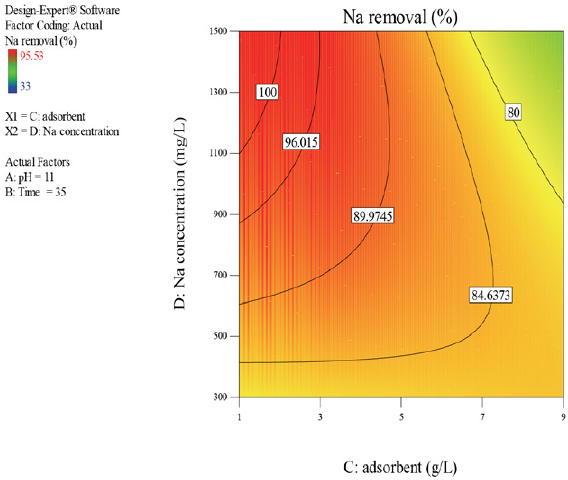
Figure 6. Effect of adsorbent dose on sodium adsorption from aqueous solutions in different concentrations of sodium ion